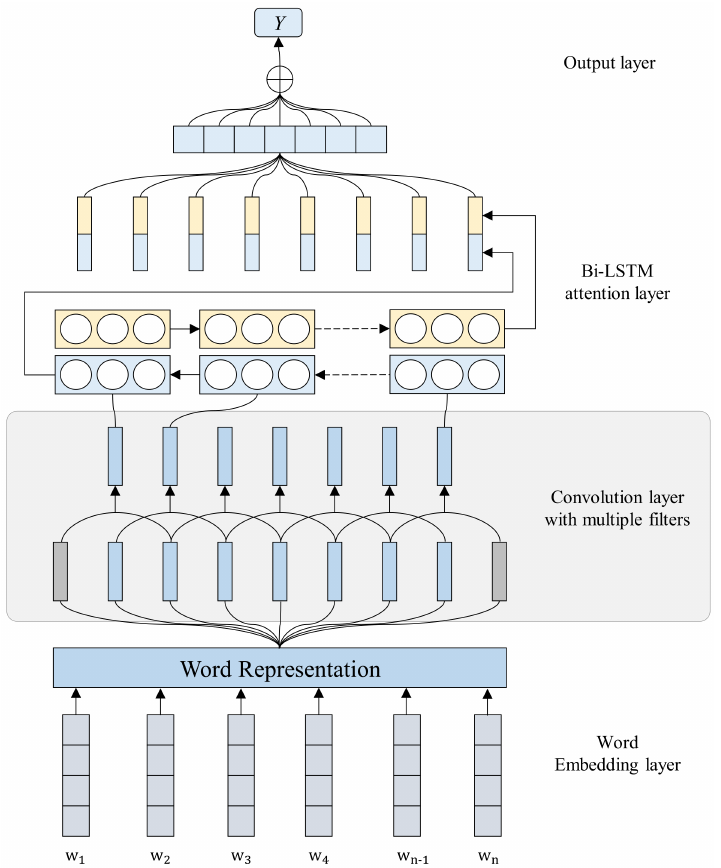
Figure 2. The architecture of CNN–BiLSTM hybrid model with the attention